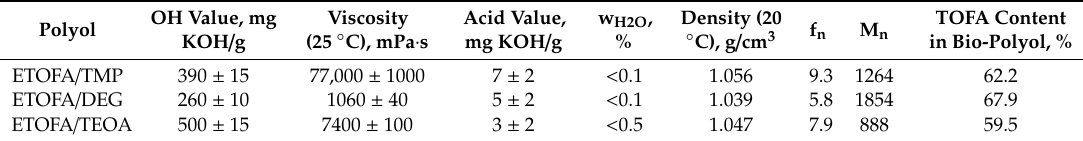
Table 1. The characterization of tall oil-based bio-polyols